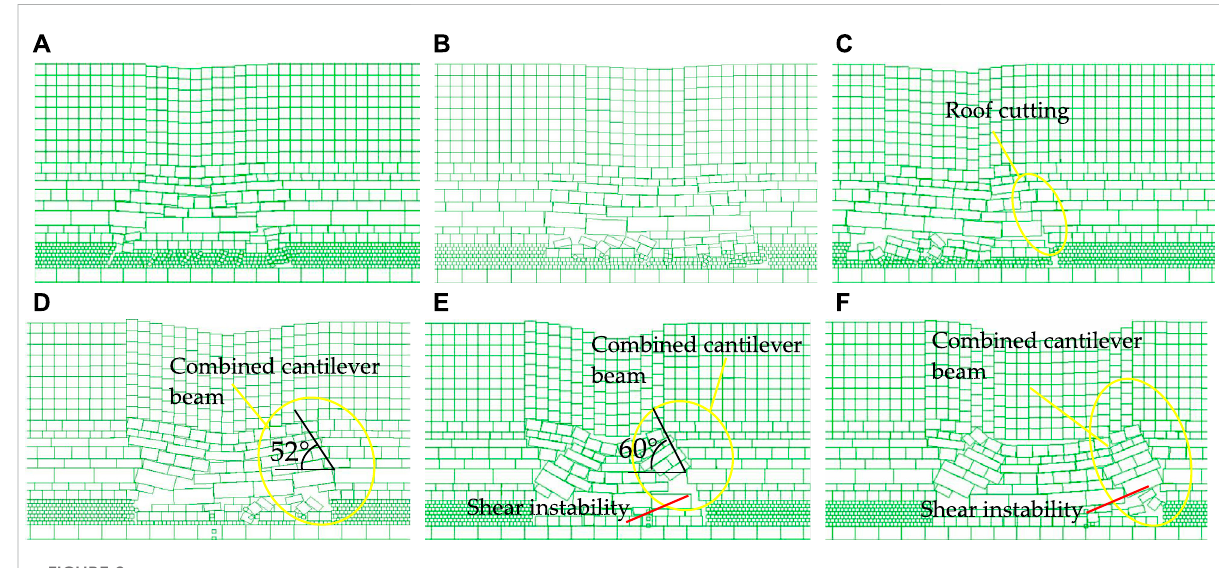
FIGURE 2 Overburden structure under weighting at different mining heights: (A) 3 m; (B) 4 m; (C) 5 m; (D) 6 m; (E) 7 m, fi rst-weighting; (F) 7 m, periodic-